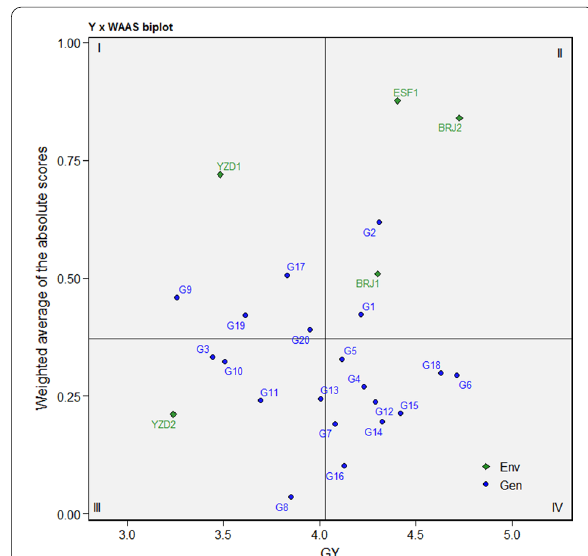
Fig. 4 The WAASB grain yield (GY) biplot for the 20 barley × genotypes in five environments. YZD1, Yazd location